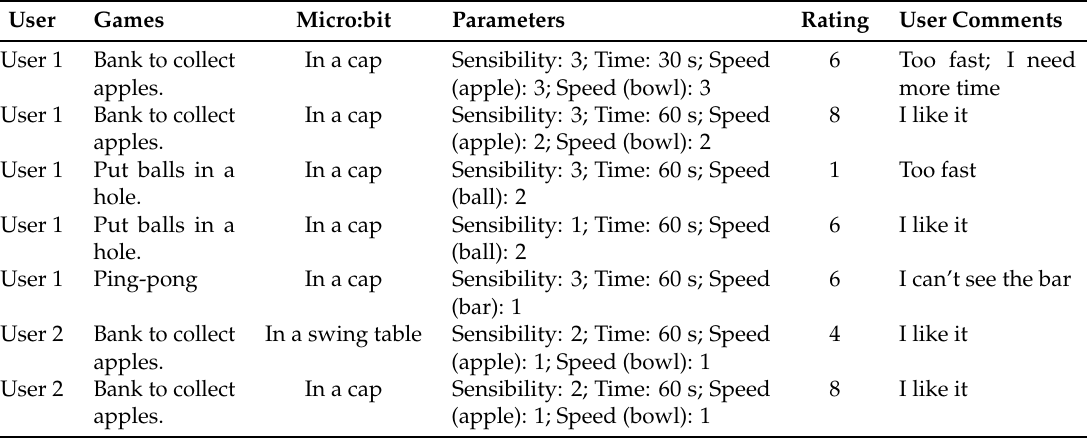
Table 1. Resume from the sessions with